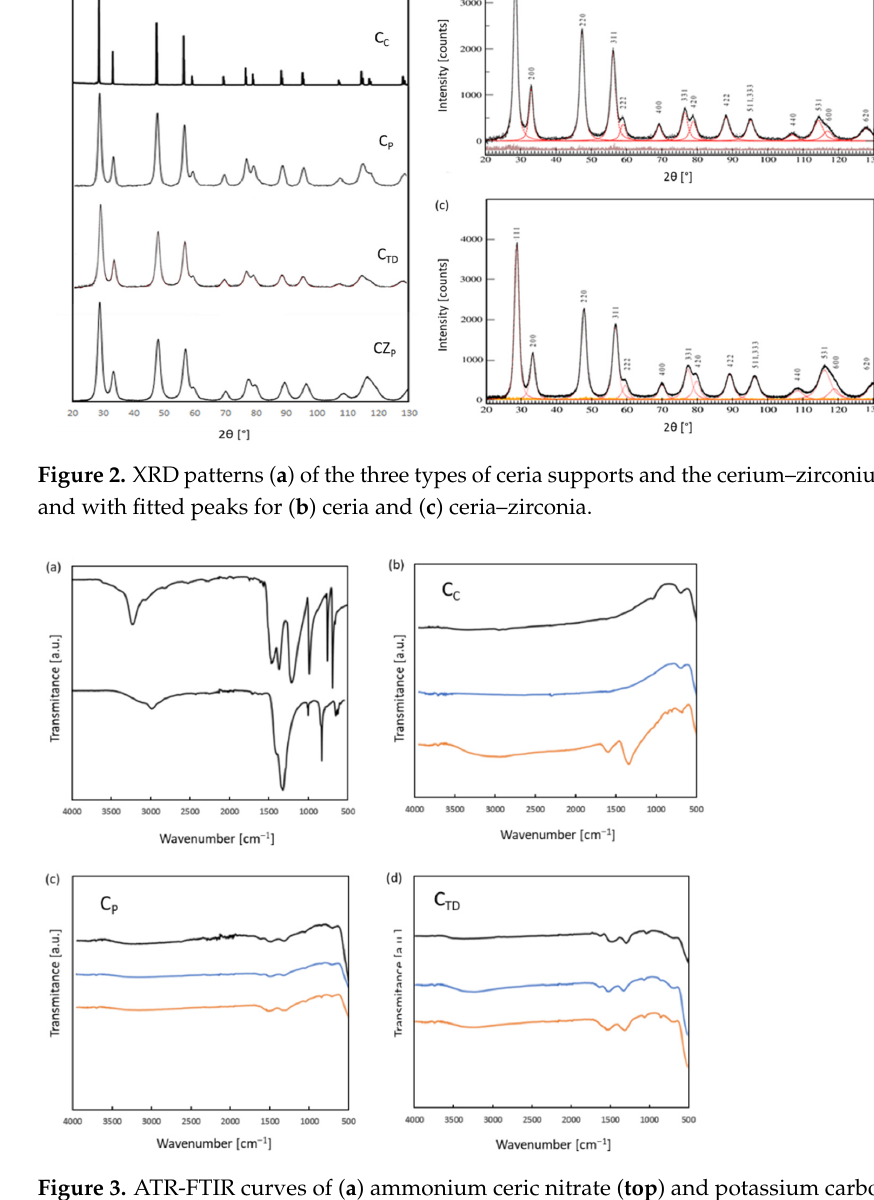
Figure 3. ATR-FTIR curves of ( a ) ammonium ceric nitrate ( top ) and potassium carbonate ( bottom ), as well as the three types of ceria supports, ( b ) C C , ( c ) C P and ( d ) C TD , without potassium (black curves) and with 0.3 at% (blue curves) and 3.0 at% (orange curves) potassium carbonate solution.